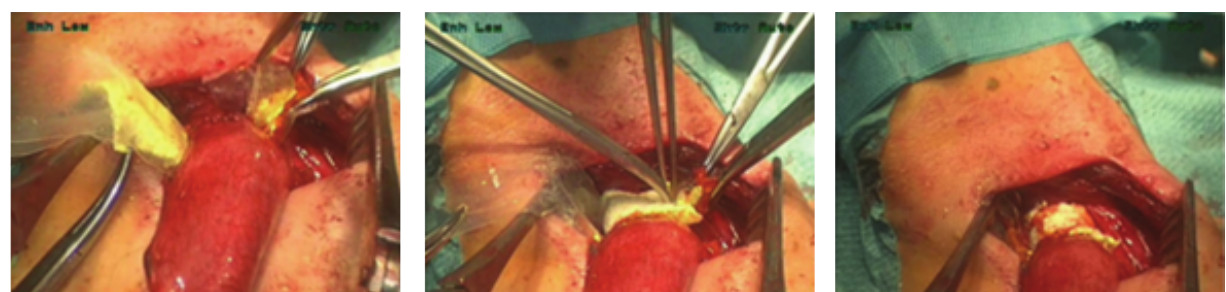
Figure 1: Strengthening the esophagogastric anastomosis with a TachoSil patch. Application by means of 2 cellophane sheets.